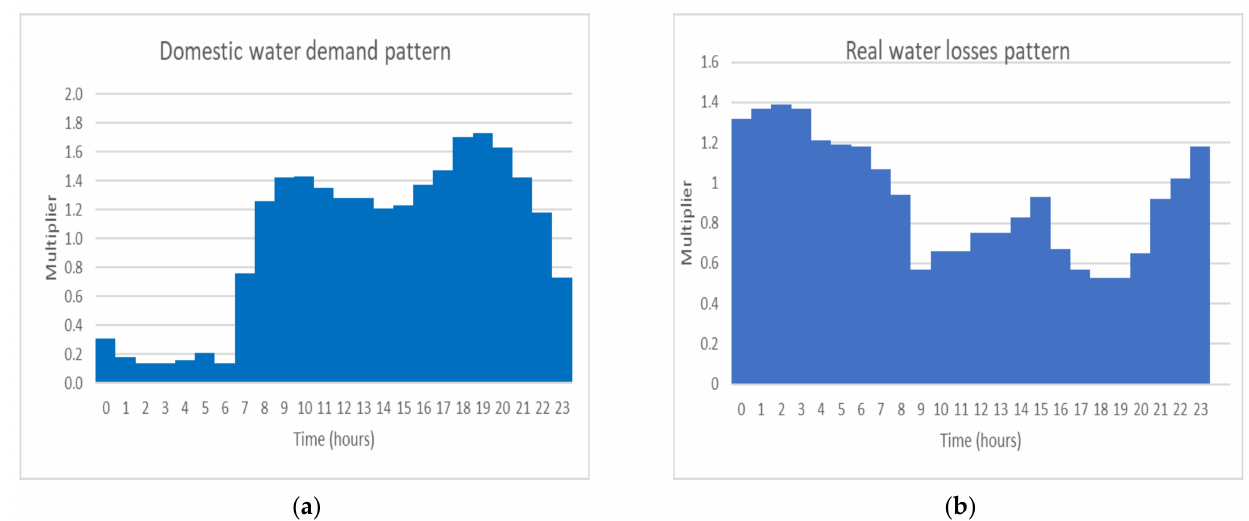
Figure 2. Water demand pattern for 24 h for ( a ) domestic water demand; ( b ) real water